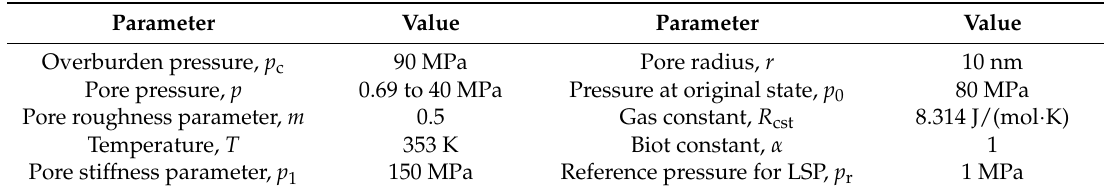
Figure 4. Validation of our LSP model by experimental data and numerical simulation. Table 4. Input parameters for LSP model validation.